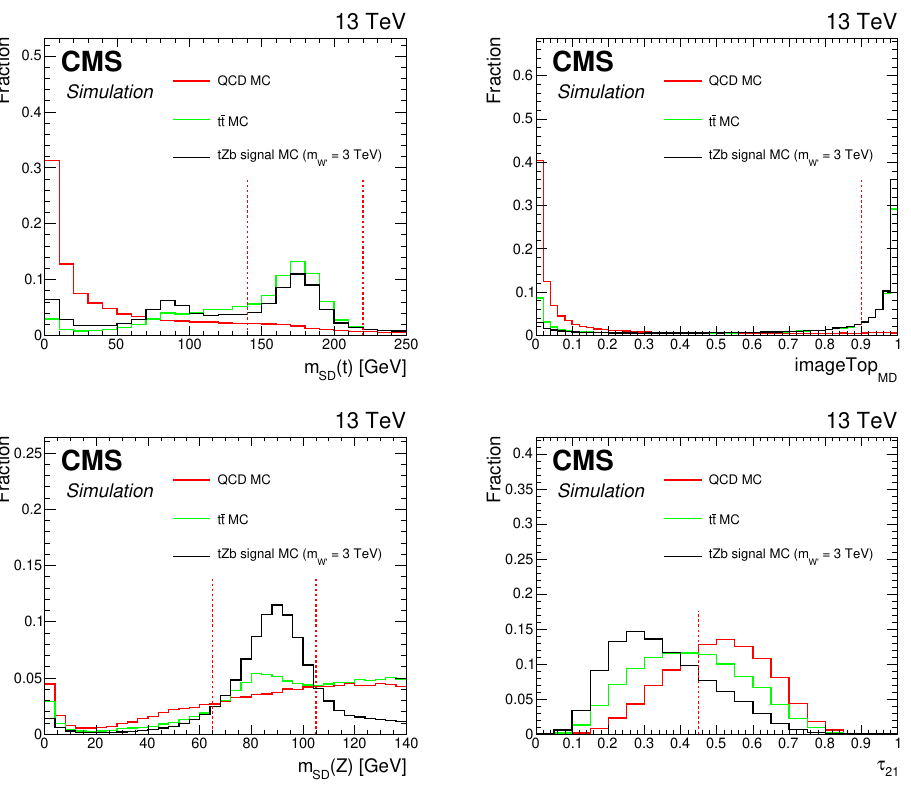
Figure 3 . Simulated distributions of the discriminating variables for tt , QCD, and tZb signal simulated events normalized to unity for the tZb analysis. Discriminant thresholds are shown as vertical dashed